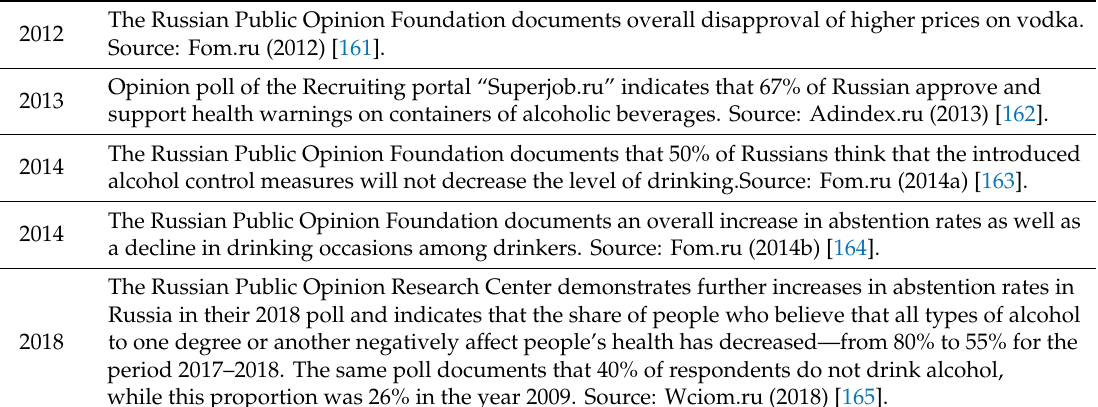
Table A9. Overview of the largest opinion polls in Russia, documenting attitudes towards alcohol and alcohol